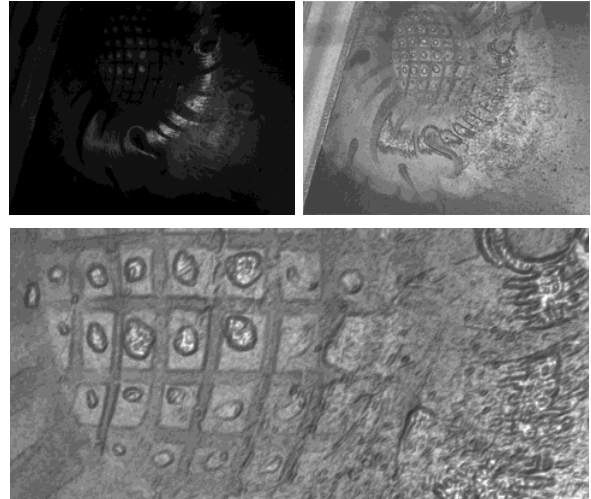
Figure 10. One of the images before and after filtering (top), and an enlarged detail (bottom).